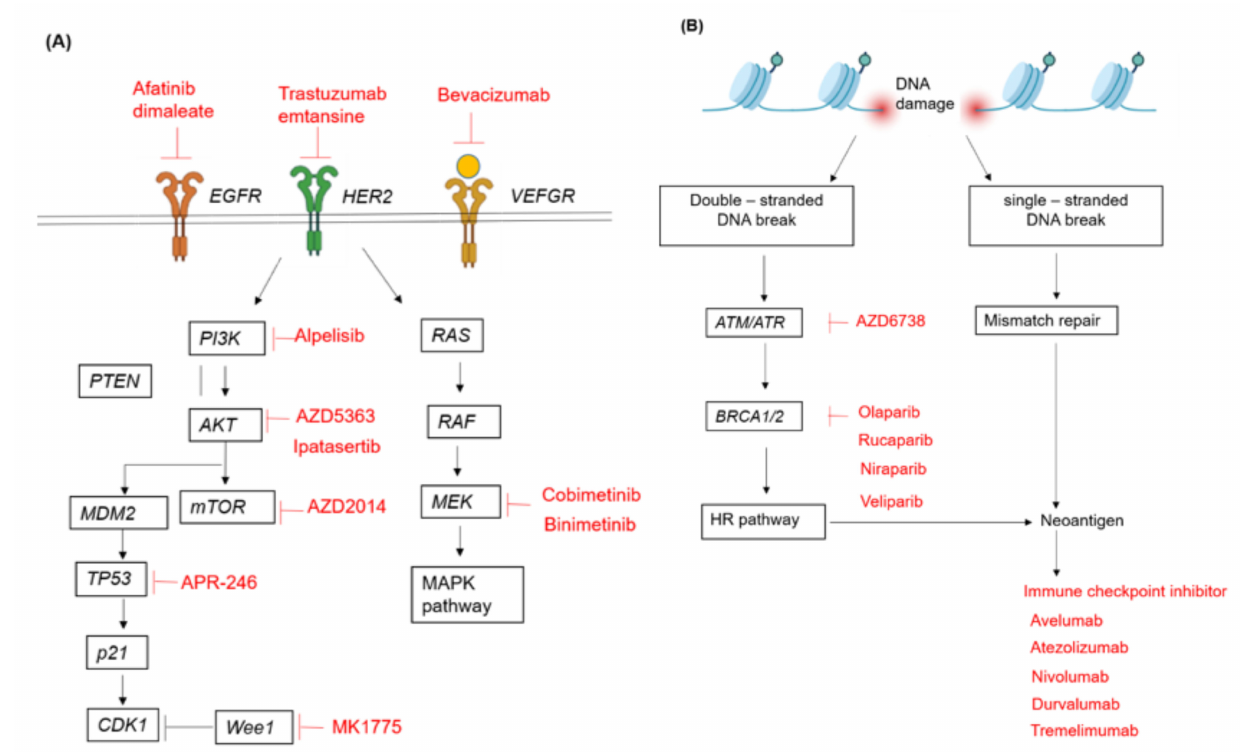
Figure 1. Altered pathways in gynecologic cancers. ( A ) The regulatory functions of oncogenic and tumor suppressor genes in the RTK (receptor tyrosine kinase) signaling pathway. ( B ) DNA damage repair pathways. The inhibitors against gene describe the rationale of therapies in cancer treatment (signed by red